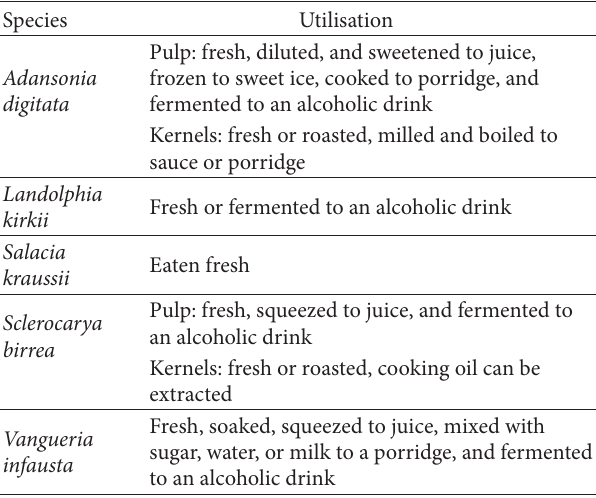
Table 3: Traditional consumption and use of the studied fruits.